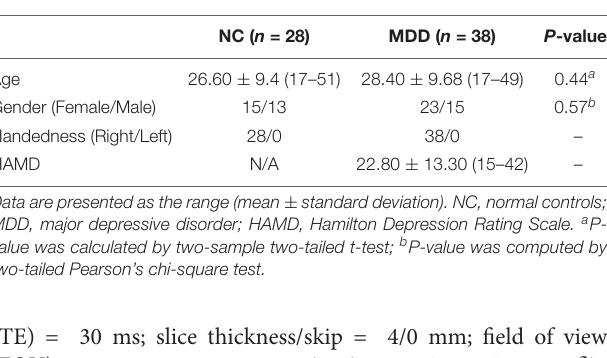
TABLE 1 | Demographic and clinical characteristics of the